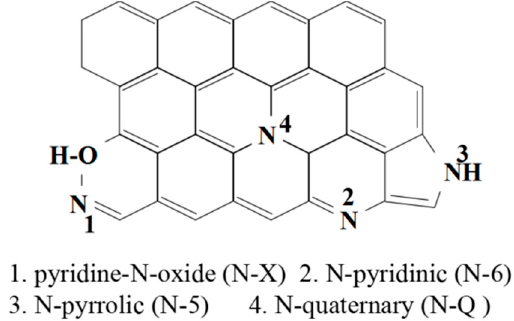
Figure 7. The chemical forms of N in nitrogen-doped carbon materials.